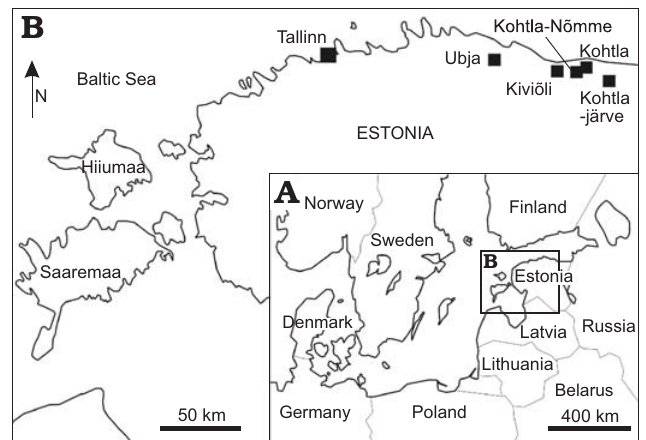
Fig. 1. Location of study area ( A ) and studied sections ( B